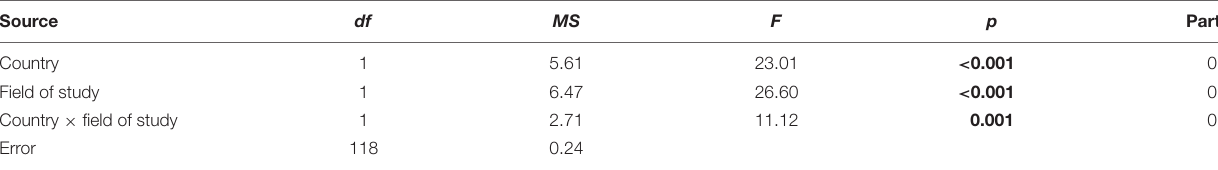
TABLE B2 | Analysis of variance of country and field of study on RT.